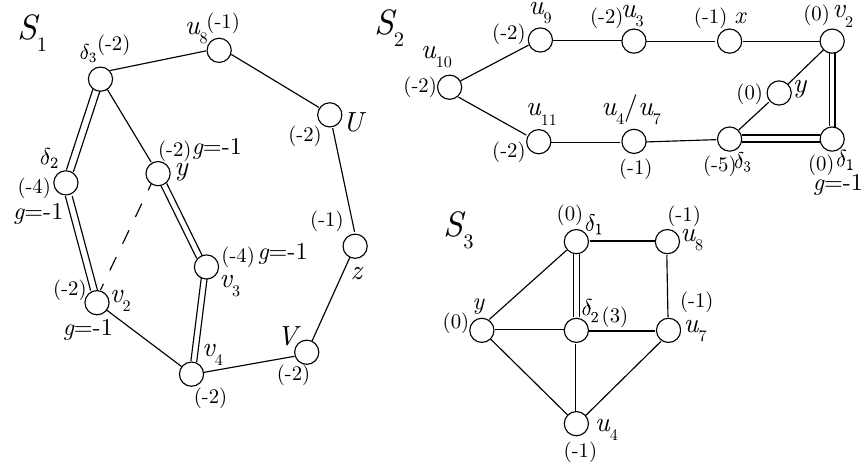
Figure 43. The con(cid:12)guration of curves S j \ f d = 0 g (cid:17) d on the compact surfaces S j